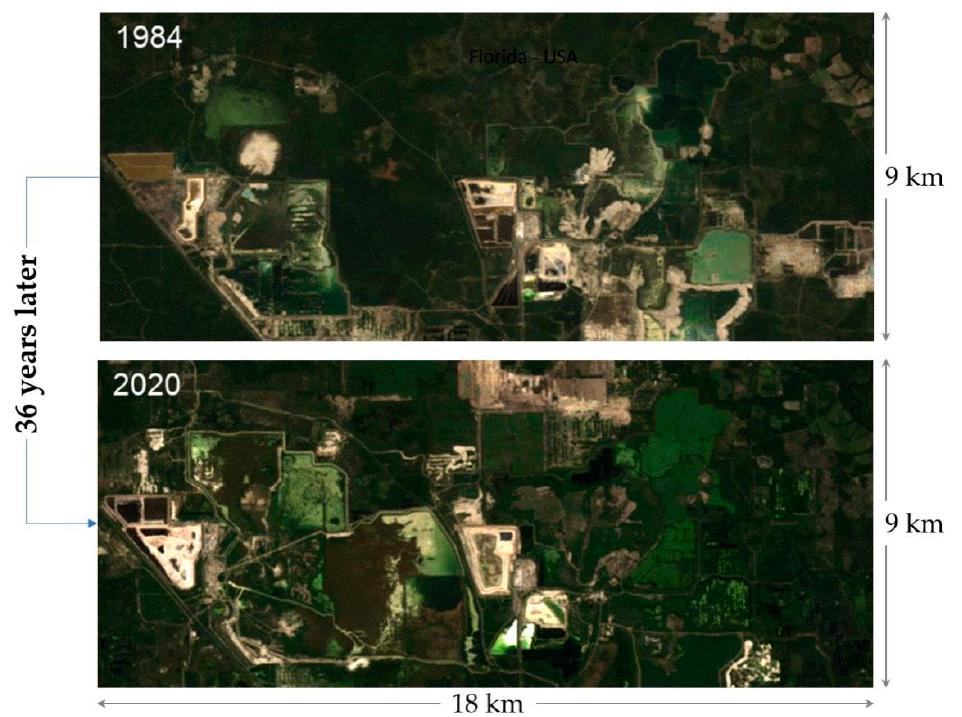
Figure 6. Satellite views of waste rock dumps and tailings ponds evolution in Florida, USA (1984 and 2020).